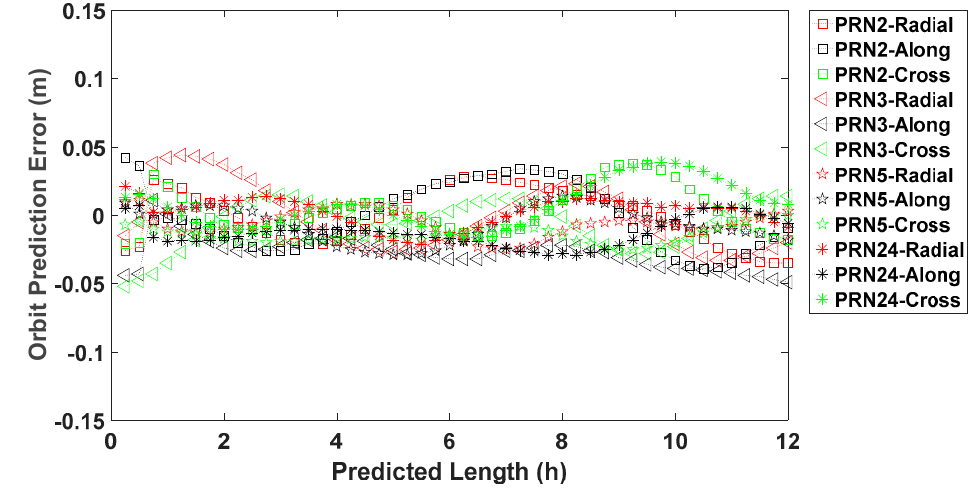
Figure 4. Orbit prediction error in the radial, along-track and cross-track directions over 12 h on DOY 109 of 2017 for GPS satellite PRN 2, PRN 3, PRN 5 and PRN 24.